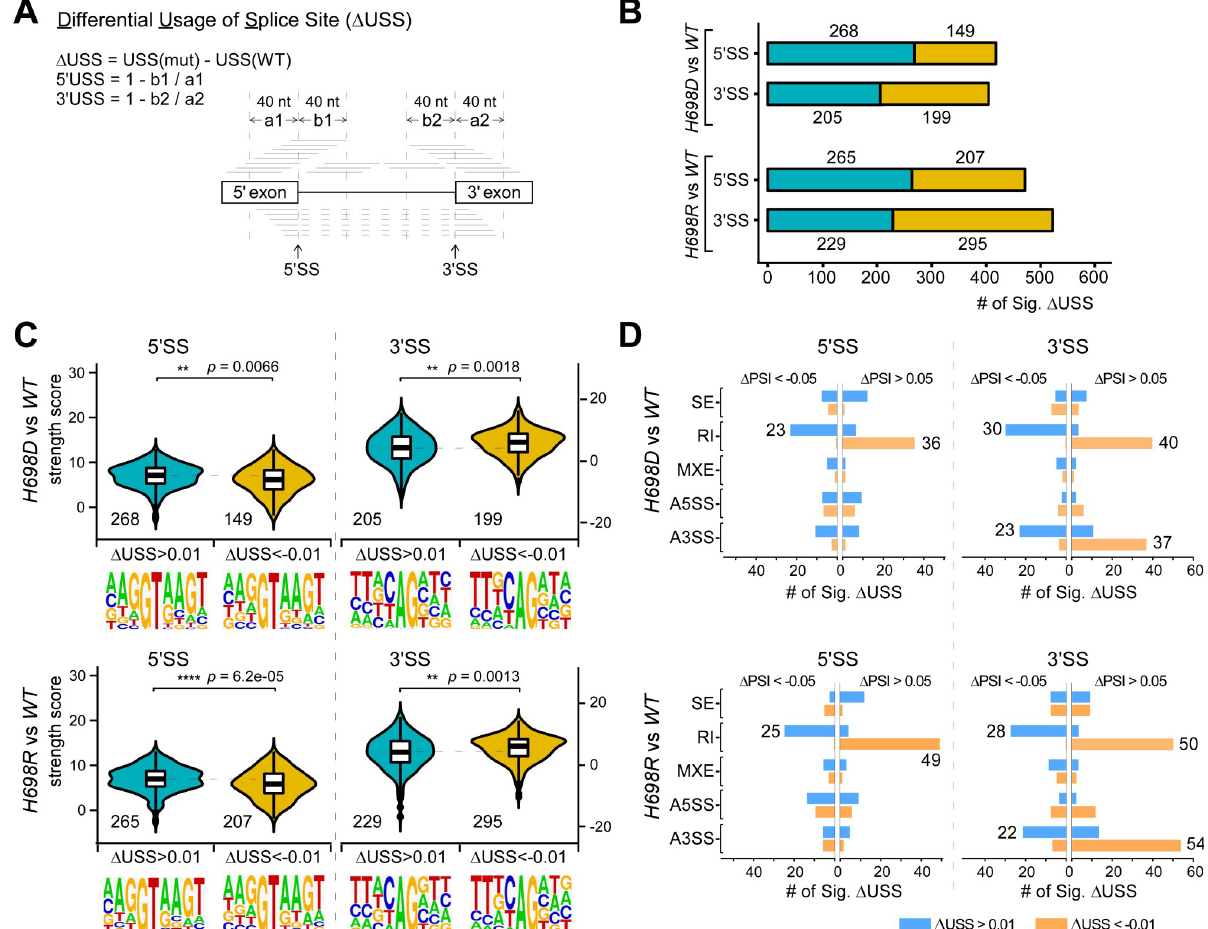
Fig 6. Differential usage of splice sites in the sf3b1 mutants. ( A ) Schematics for analysis of Δ USS between fly strains. Transcriptome-wide usages of all Drosophila splice sites were individually analyzed by the USS, in which a1 and b1 are coverage of reads that located in the downstream 40 nt of 5 0 exons and upstream 40 nt of the 5 0 introns, respectively. Similarly, a2 and b2 are coverage of reads that used for USS analysis of 3 0 splice sites. ( B ) Significantly changed USSs in the sf3b1 mutants. The 5 0 and 3 0 SSs with | Δ USS| > 0.01, FDR < 0.05 were screened in H698D and H698R . Blue: Δ USS > 0.01, brown: Δ USS < -0.01. ( C ) Comparison of splicing signals between SSs with significant changes in usage. The strength of splicing signals was scored by MaxEntScan using the 9-nt sequences of 5 0 SSs and the 23-nt sequences of 3 0 SSs [89]. The consensus sequences are visualized by WebLogo [90]. ( D ) AS events from the RI and A3SS groups are enriched in the significantly changed USSs. Left, only the RI-events are enriched in the significantly changed usage of 5 0 SSs; Right, events from the RI and A3SS groups are enriched in the significantly changed usage of 3 0 SSs.